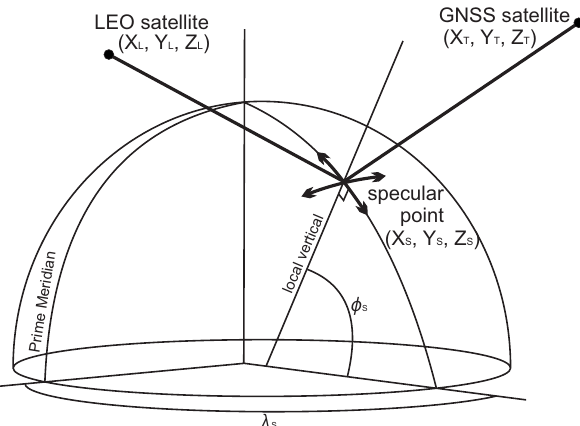
Fig. 2. Specular reflection point geometry for a GNSS signal path transmitted from a GNSS satellite T, reflected at specular point S and received at the LEO satellite L (from Garrison et al.